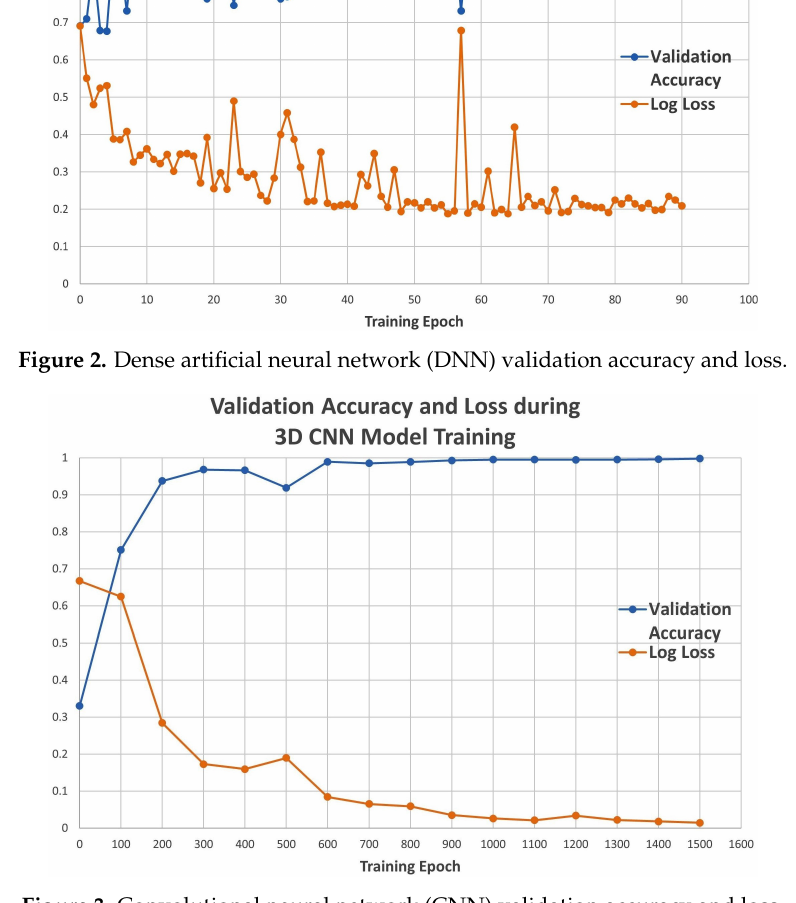
Figure 3. Convolutional neural network (CNN) validation accuracy and